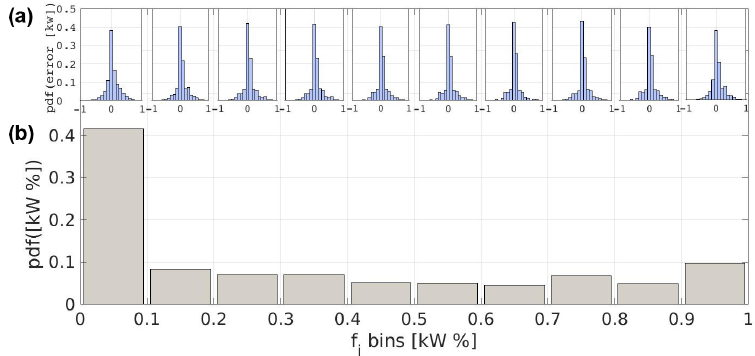
Figure 4. Probability density of wind power error in the different quantiles of Pn (b) and distributions of error for each quantile (a) , for park B.